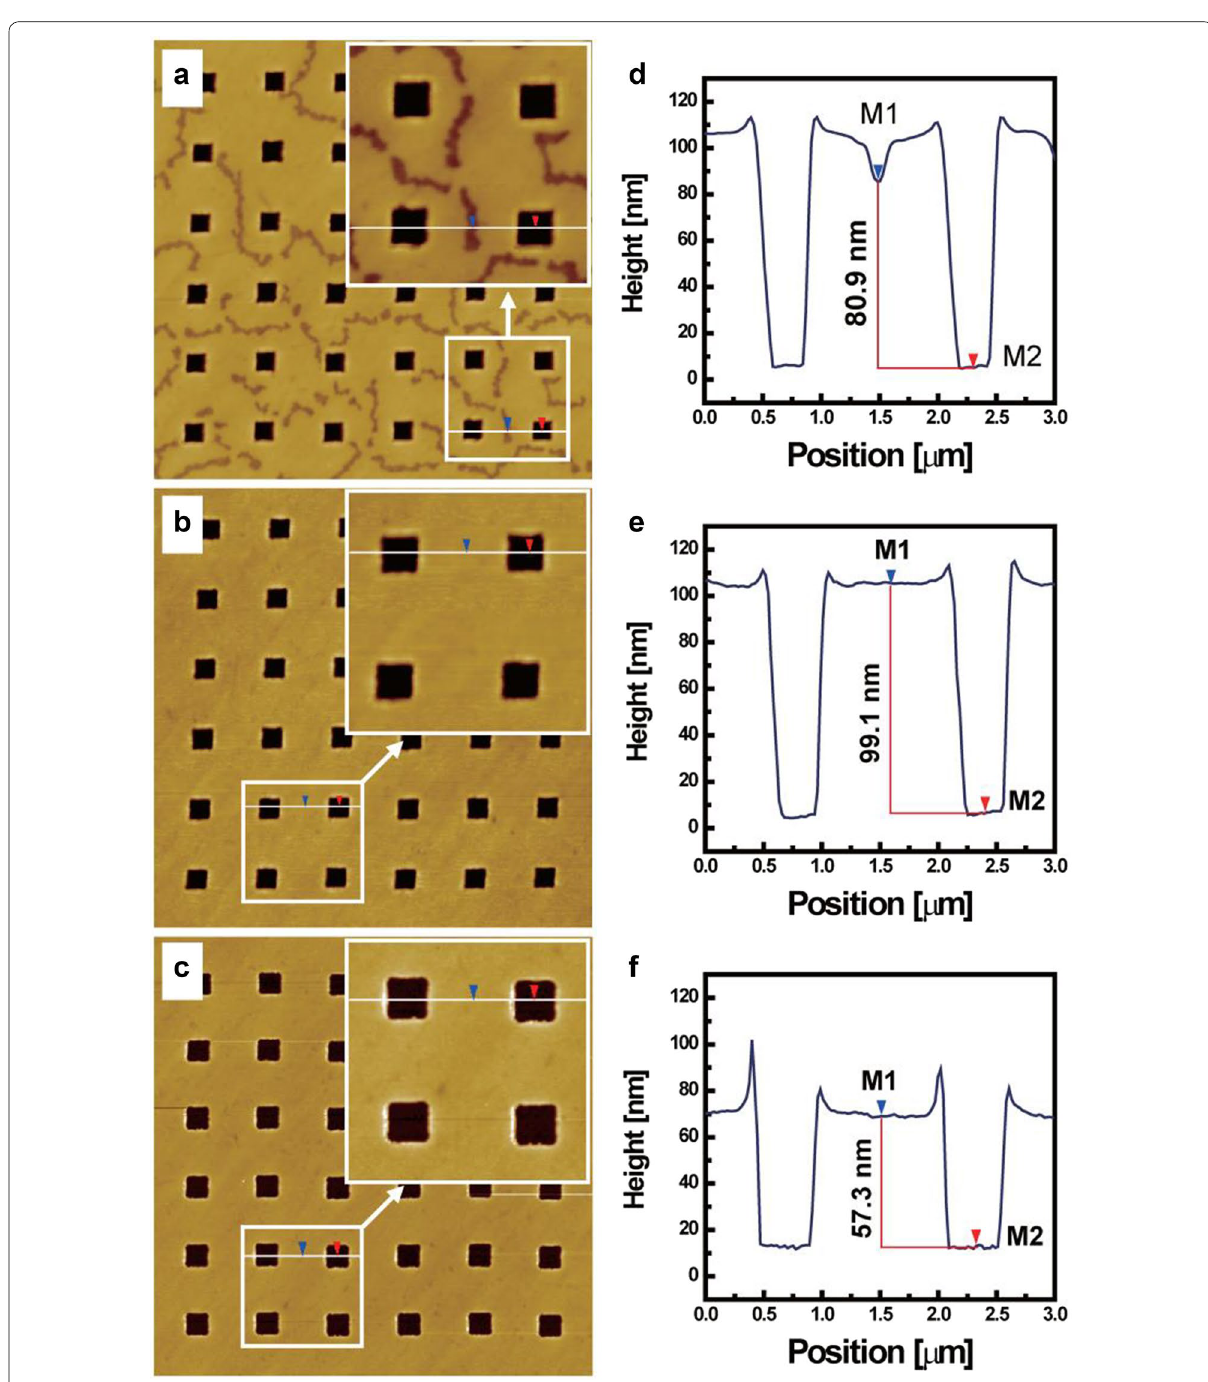
Fig. 9 a – c Height and d – f cross-sectional TM-AFM images of 500-nm patterns of PEGDA575 hydrogel on gold substrates in air. a , d Mold-detached state after being prebaked at 80 °C for 10 min. b , e Molddetached state, and c , f O2 RIE finished state after being prebaked at 100 °C for 10 min